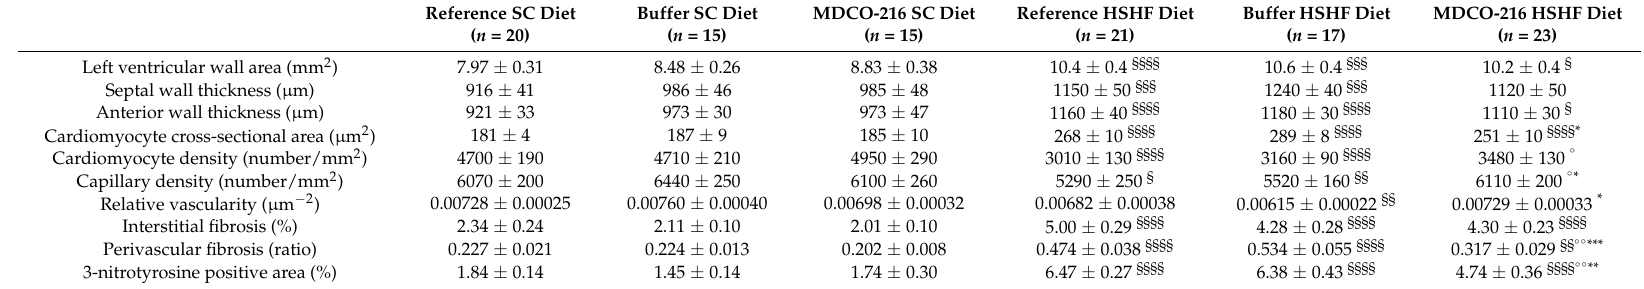
Table 5. Morphometric and histological parameters of the left ventricular myocardium in reference, buffer, and MDCO-216 C57BL/6N